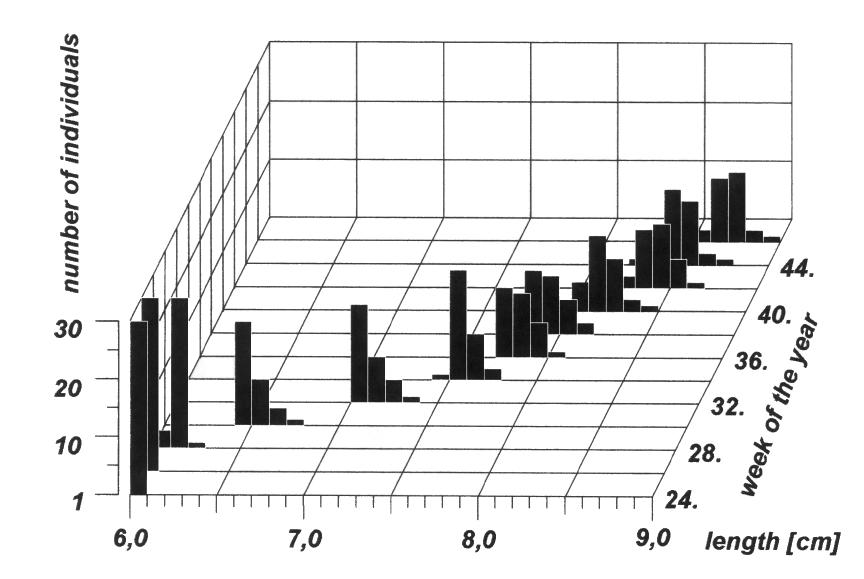
FIGURE 5. Simulation output for the length differentiation in a cohort of 30 young roaches. The simulation starts with individuals of 6 cm in length. Due to the movement pattern and the environmental structure of Lake Belau (see Fig. 4) a positive feedback results, which increases minimal random differences and leads to a characteristic size spectrum even if there is no genetic variability